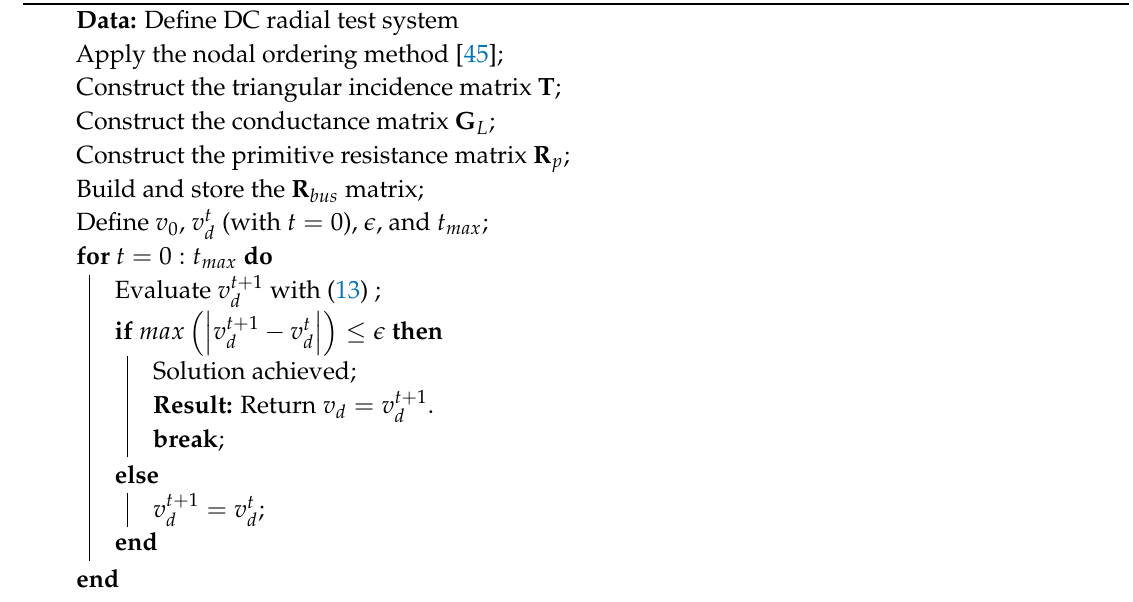
Algorithm 2: Proposed iterative power-flow method for DC resistive networks based on triangular matrix (TM)